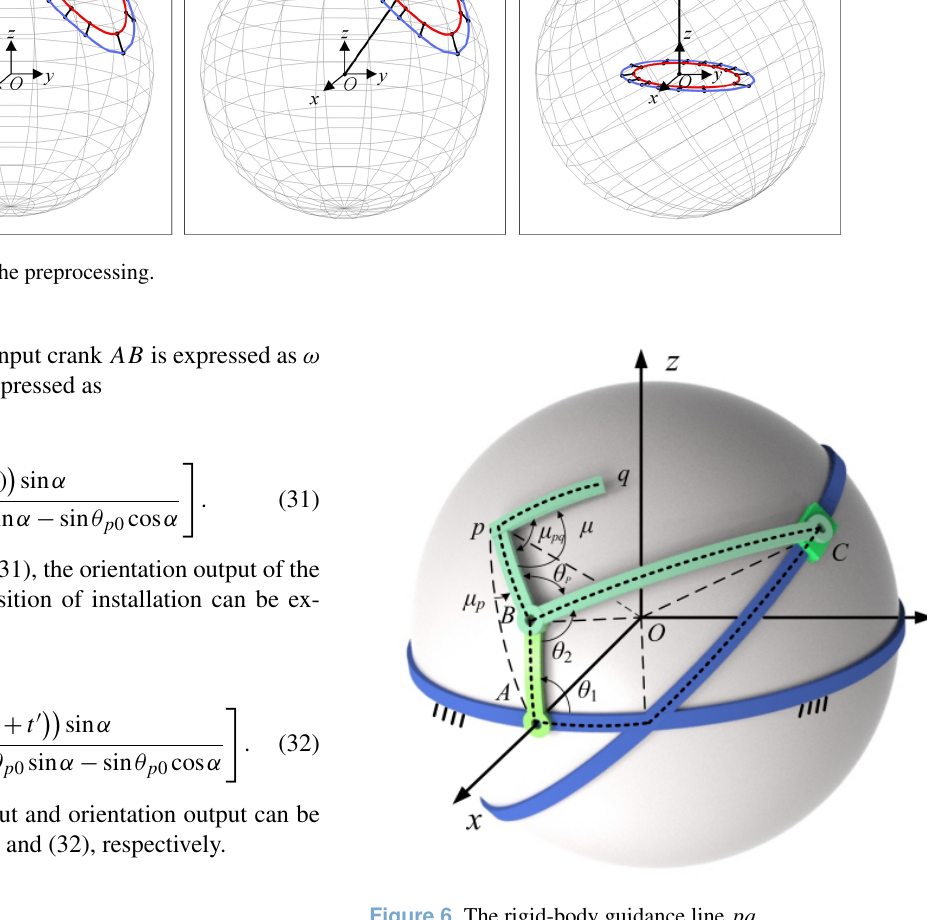
Figure 6. The rigid-body guidance line pq